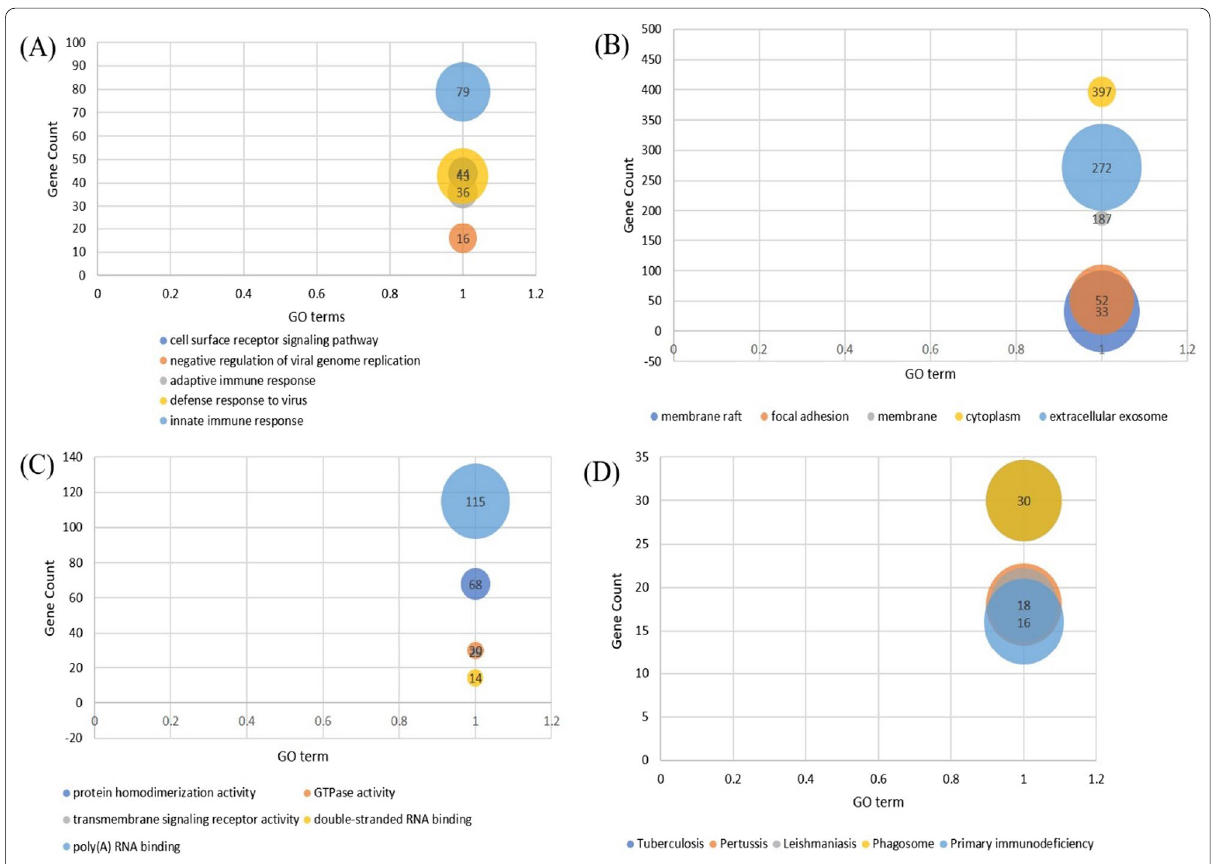
Fig. 1 The functional enrichment analysis of DEGs was performed by DAVID (https:// david. ncifc rf. gov/ tools. jsp). GO functional enrichment analysis results from DEGs relating to A biological process, B cellular components, C molecular function and D KEGG pathways. The size of the bubble represents the number of genes associated with the